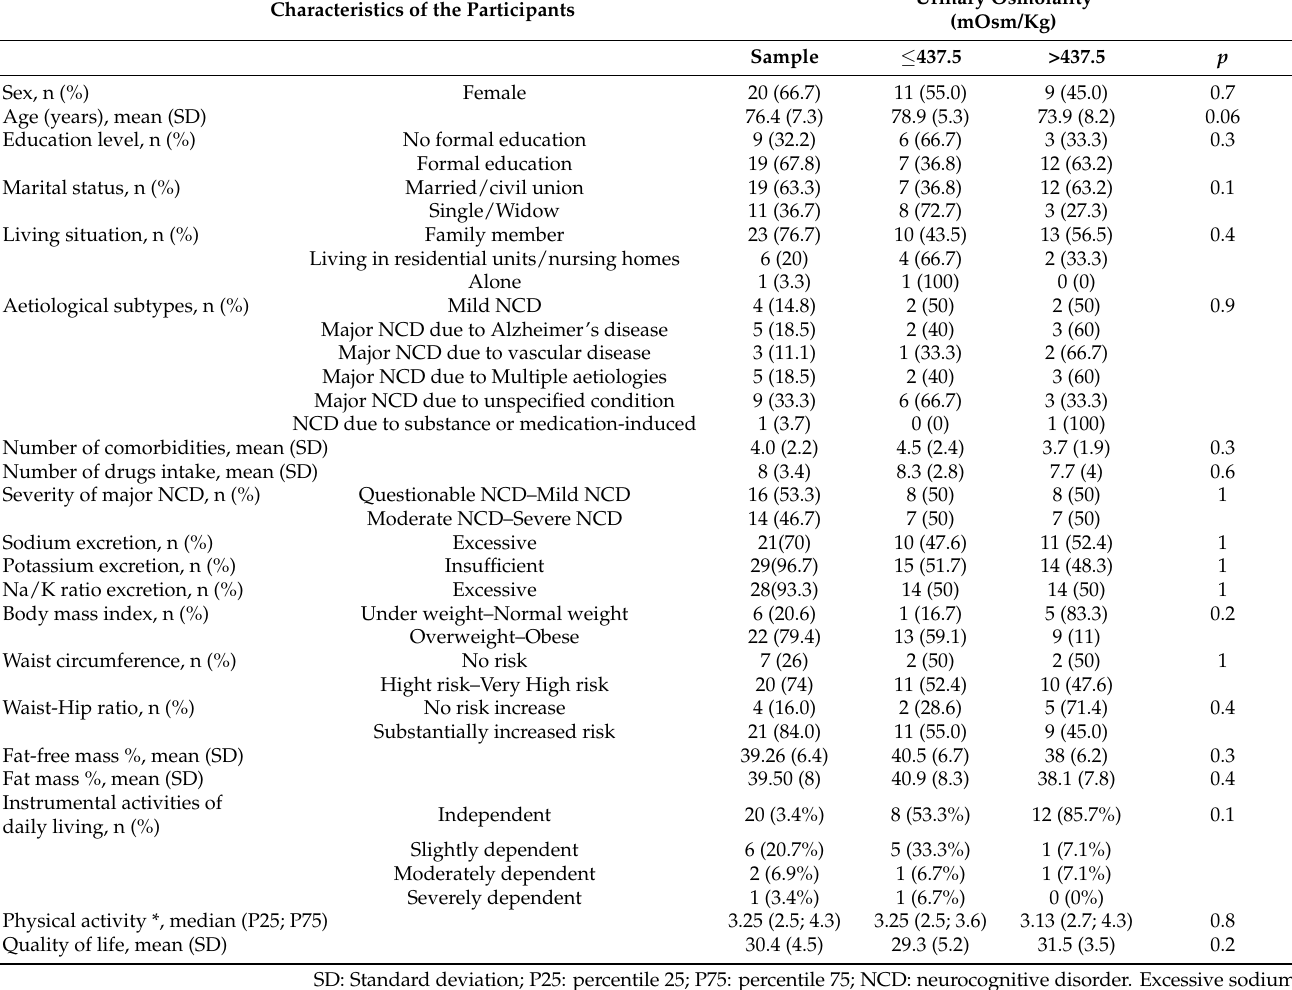
Table 2. Characteristics of the participants according to the median urinary